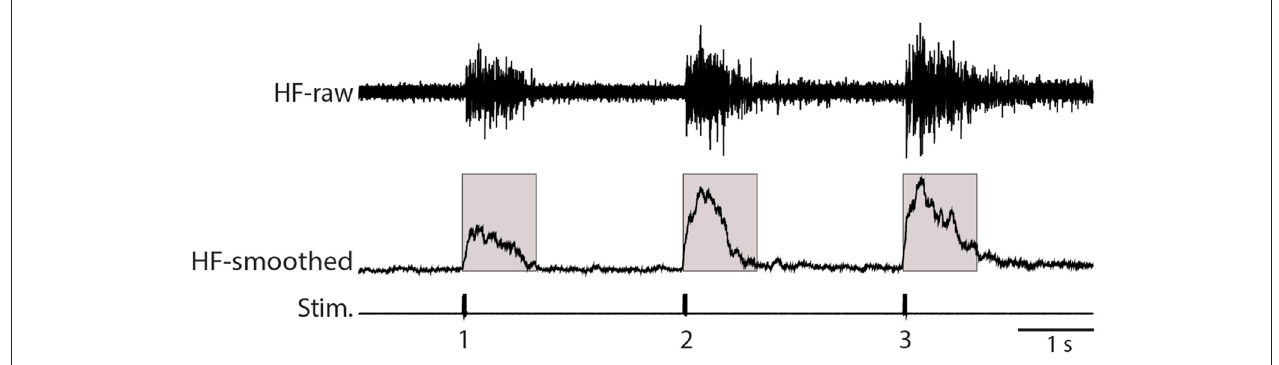
FIGURE 1 | Illustration of analysis methods. The raw recording of the hip flexor (HF) nerve (top, HF-raw) was rectified and smoothed using a 100-ms sliding window (middle, HF-smoothed). The mean value of this rectified and smoothed signal (with the baseline adjusted to zero) was calculated over the 1.0 s following each stimulus (indicated by the shaded boxes). Stim.,